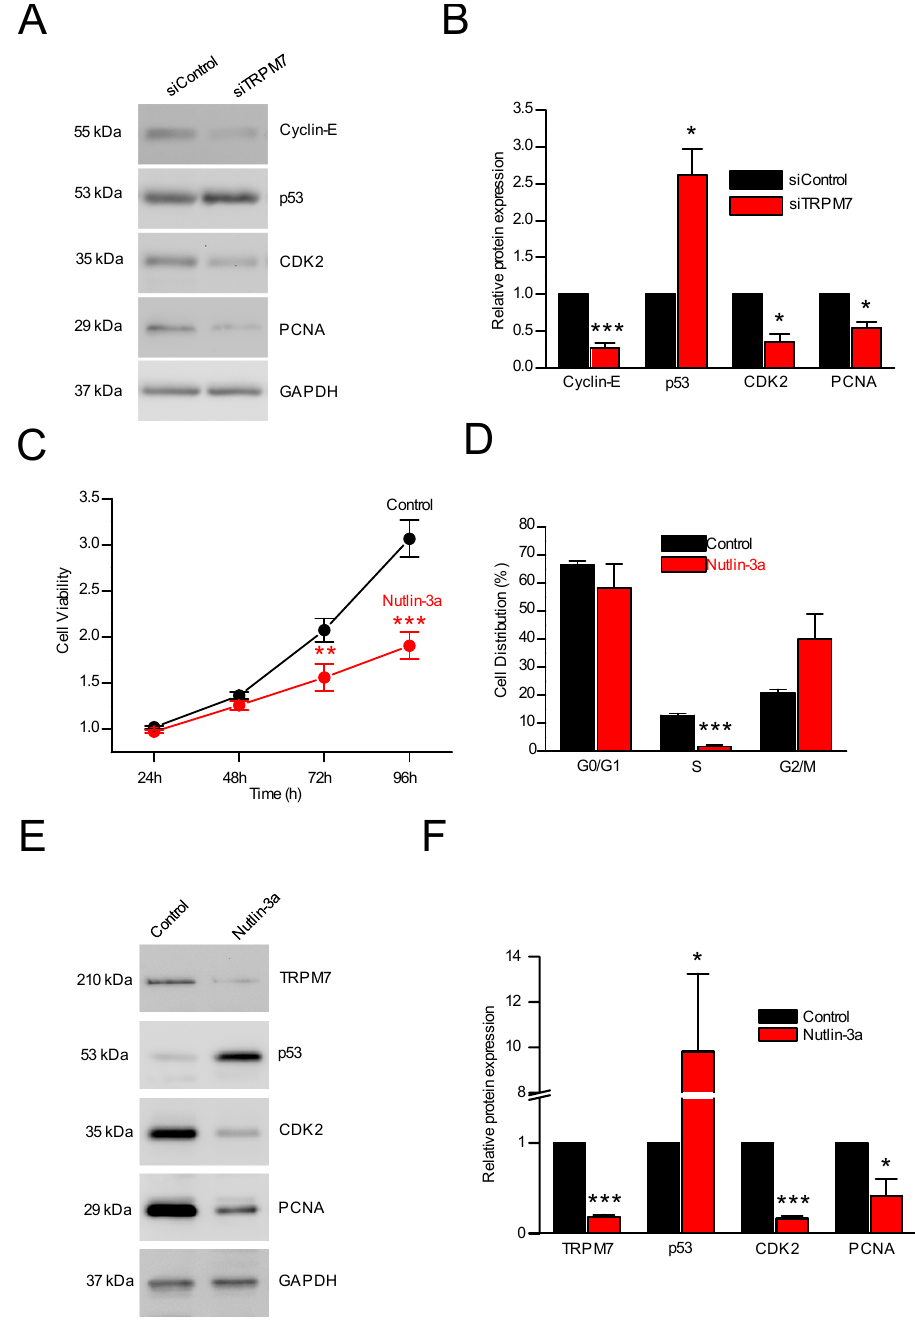
Figure 3. Influence of TRPM7 on cell cycle regulators (cyclin E, p53, CDK2, and PCNA expressions). ( A ) Immunoblotting of PS − 1 protein lysates. The cells were transfected with a scramble siRNA (siControl) or a siRNA targeting TRPM7 (siTRPM7) and incubated with the following antibodies: anti − Cyclin − E, anti − p53, anti − CDK2, anti − PCNA, and anti − GADPH. ( B ) Quantification of Cyclin-E, p53, CDK2, and PCNA protein expression in PS − 1 cells transfected with a scramble siRNA (siControl) or a TRPM7 targeting siRNA (siTRPM7) ( n = 4–8). * indicates p < 0.05 (Mann-Withney Rank Sum Test). ( C ) Cell viability without (Control) or with Nutlin-3, an inhibitor of the main p53 regulator, Mdm-2 ( n = 4). ** indicates p < 0.01 and *** indicates p < 0.001 (2 − ways ANOVA). ( D ) Following nutlin-3 treatment, the percentage of PS-1 cells was decreased in S phase ( n = 3). *** indi- cates p < 0.001 (2 − ways ANOVA). ( E ) Western blots showing TRPM7, p53, CDK2, PCNA, GAPDH